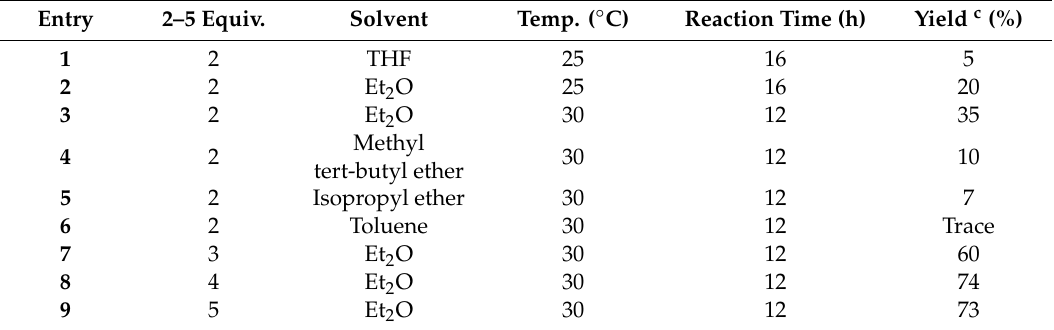
1. Optimization of the reaction conditions a,b for the synthesis